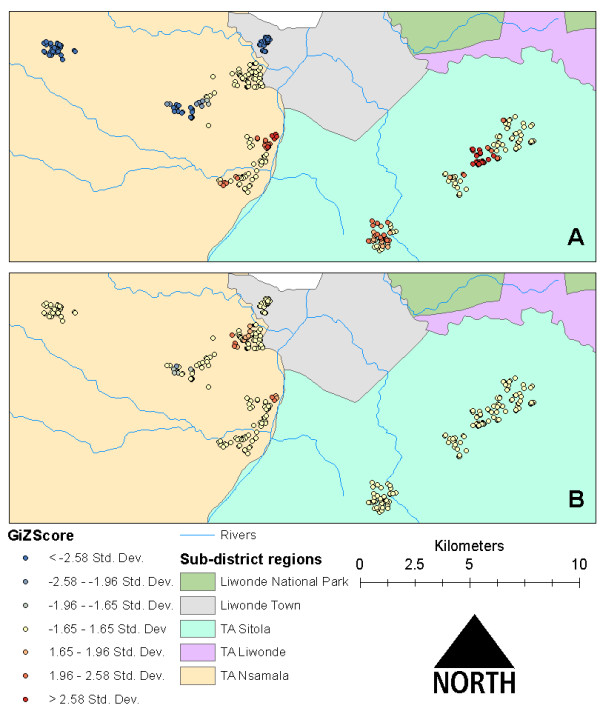
Comparison of residual clustering of
Plasmodium
infection of children in households near Liwonde, Malawi based on A) simple logistic regression and B) multilevel logistic regression models.